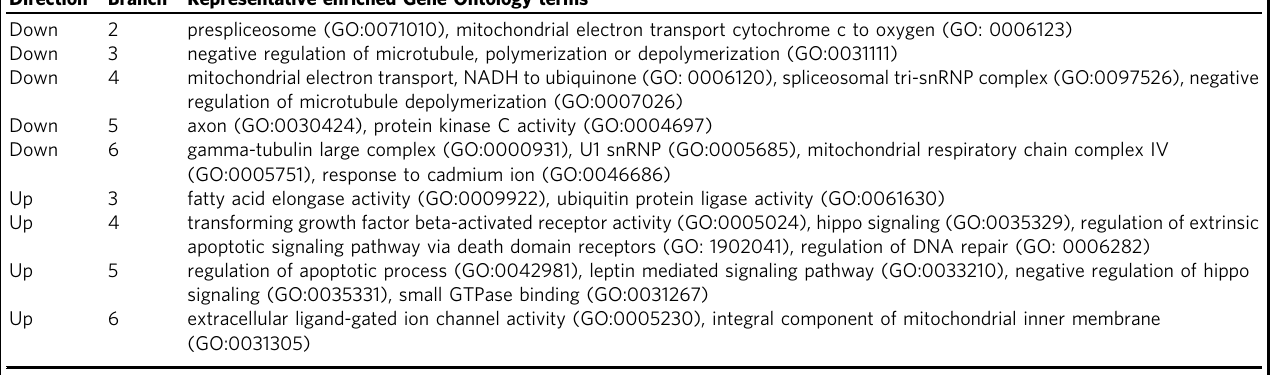
Table 1 Pathway enrichments for branch-speci fi c differentially expressed genes in TCX. Direction Branch Representative enriched Gene Ontology terms